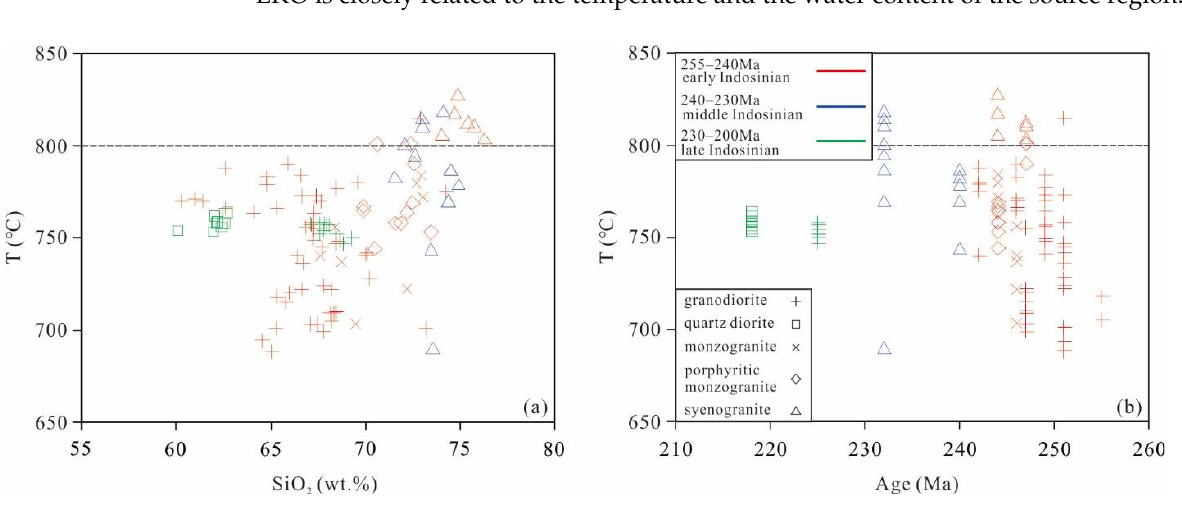
Figure 10. Diagrams of ( a ) T vs. SiO 2 and ( b ) T vs. age for the Indosinian granite plutons in the eastern region of the EKO.